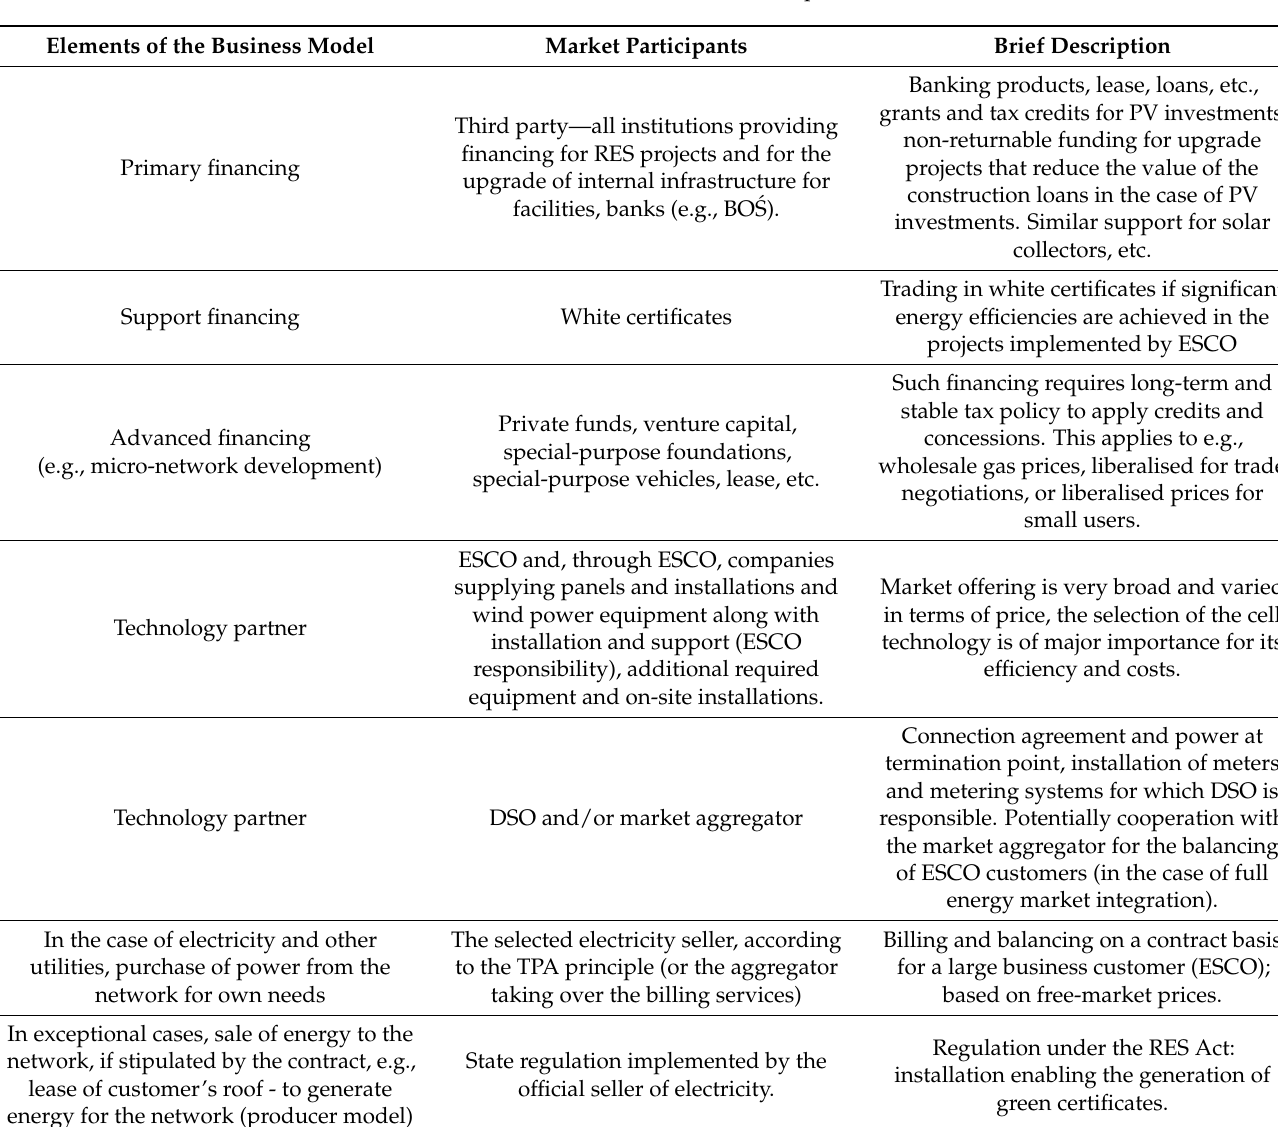
Table 2. Characteristics of ESCO business model parameters for RES